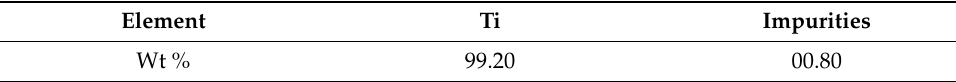
Table 1. Chemical composition of the titanium locking plate.